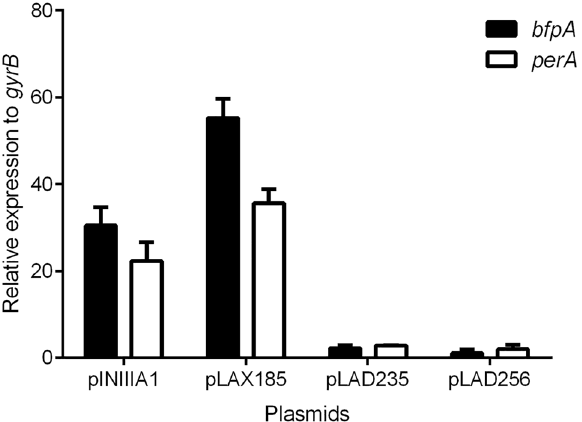
Figure 3. Expression of bfpA and perA is affected in RpoA CTD dominant negative mutants. Transcriptional expression of the bfpA and perA genes in EPEC WT strains transformed with pNIIIA1, pLAX185, pLAD235 and pLAD256 was detected by RT-qPCR. The strains were grown in inducing conditions in DMEM media at 37ºC supplemented with 0.25 mM IPTG to an D.O. 600 = 0.8. Graph represents the mean of two independent experiments performed in triplicates, error bars represent the standard error and the bars indicate the average of the relative expression compared to the endogenous genes gyrB